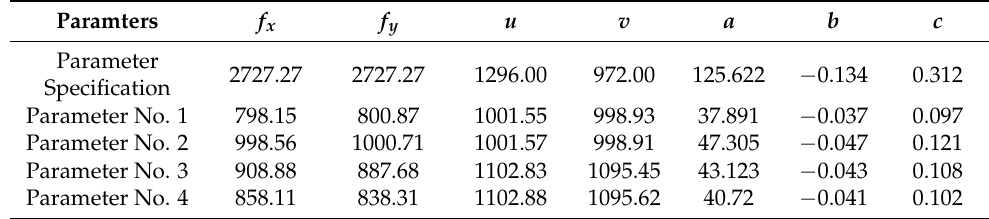
Table 1. The calibration